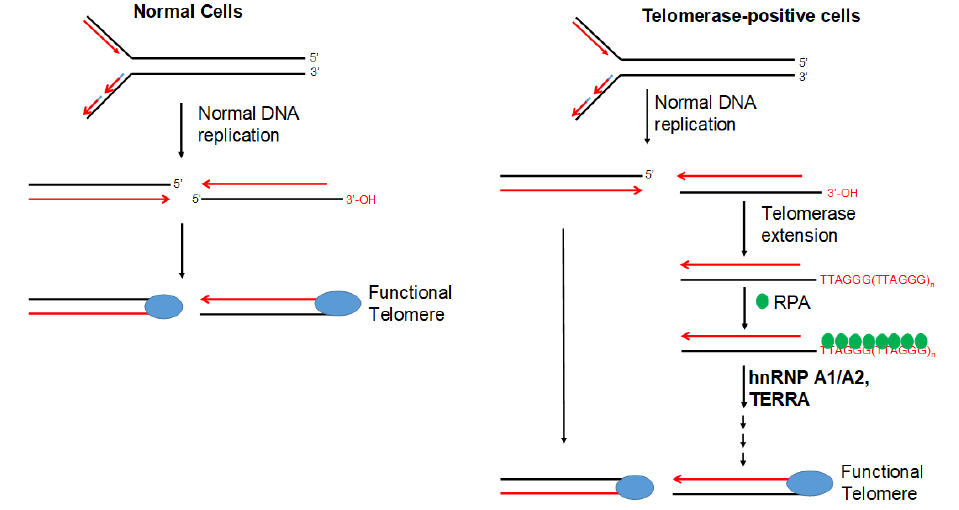
Figure 7. Model of telomerase-dependent maintenance of telomeres. Normal cells do not express telomerase, and the ends of their chromosomes are replicated by regular DNA replication